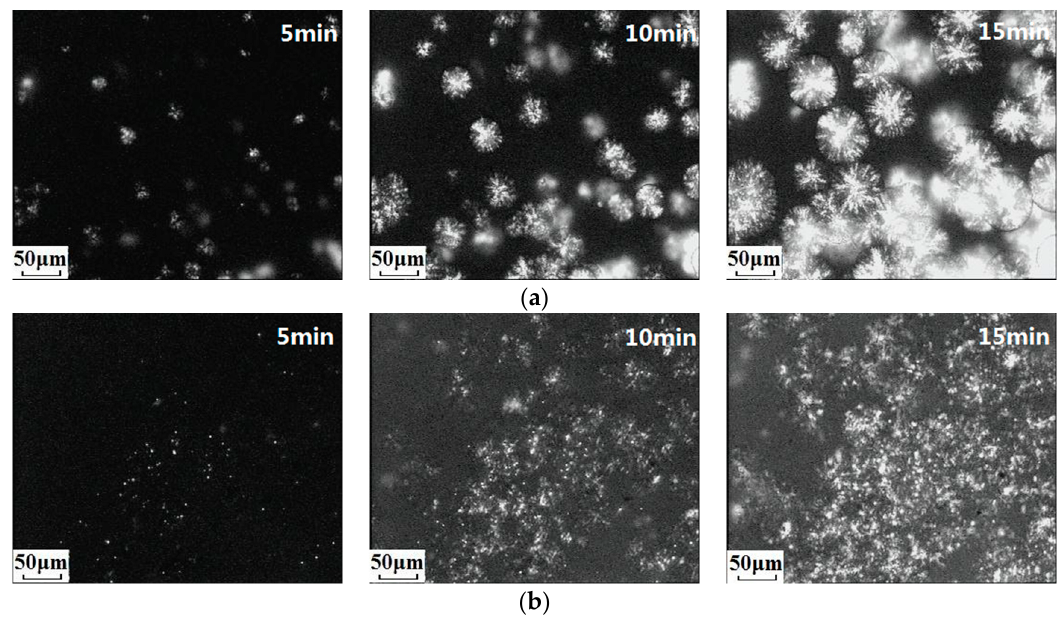
Figure 2. Polarized optical micrographs of ( a ) iPP/PEOc-80/20; and ( b ) iPP/PEOc-40/60 during isothermal crystallization at 140 °C for 5, 10 and 15 min, respectively, left to right.